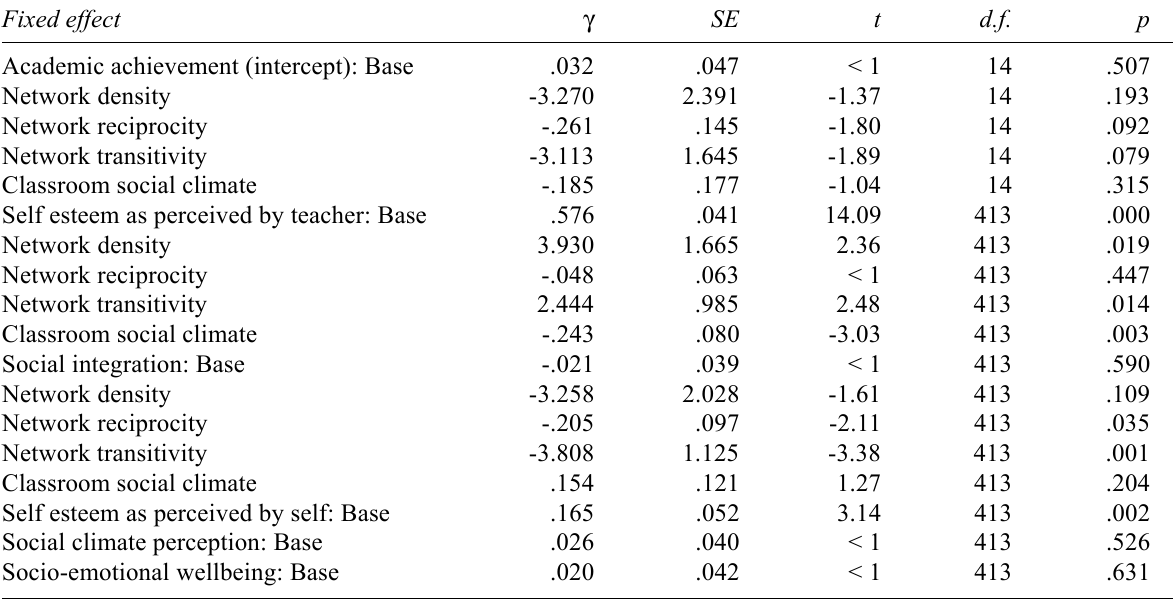
Final Hierarchical Linear Model predicting Academic Achievement Fixed